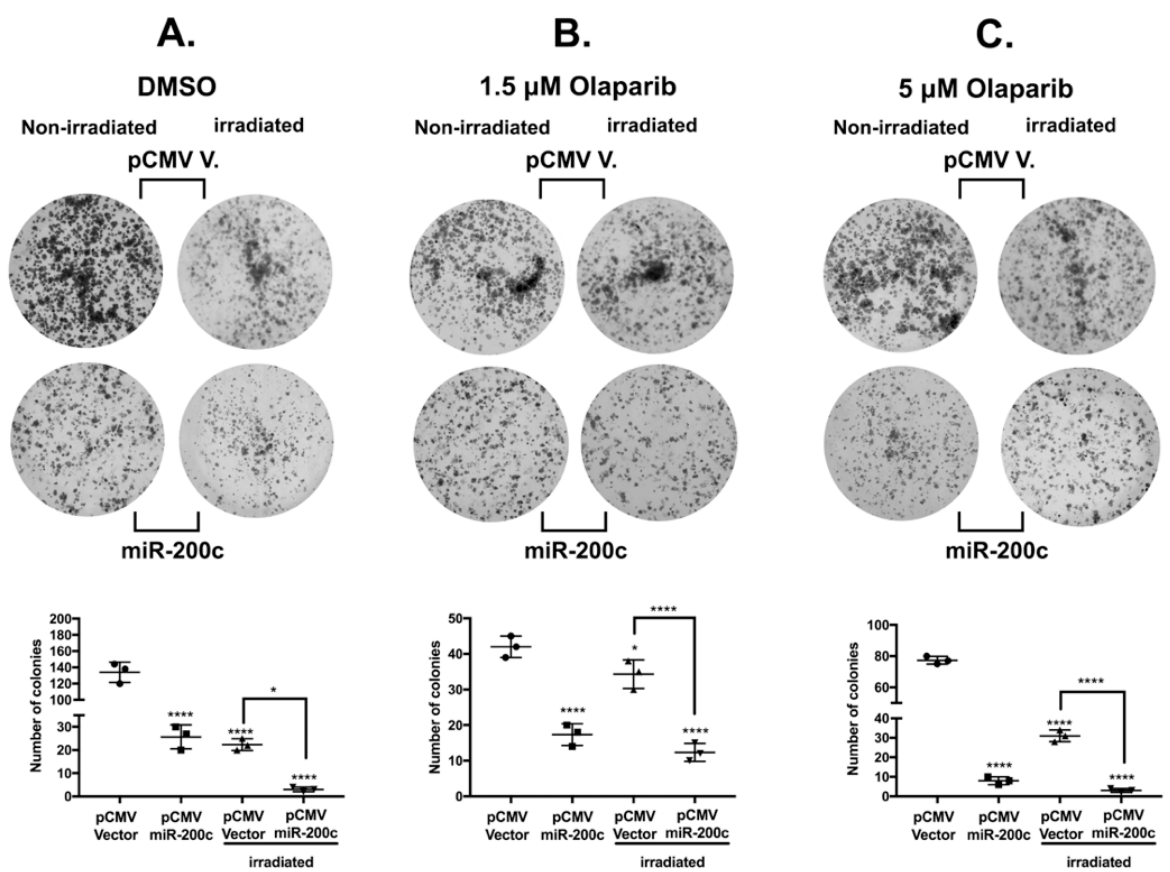
Figure 6. MiR-200c reduces colony formation of the SKOV3 cell line. ( A – C ): Representative images of one well out of three for each experimental condition of the colony formation assay, after two weeks. Under all of the experimental conditions: untreated (DMSO), irradiated only, 1.5 µM olaparib and 5 µM olaparib alone or in combination with irradiation, the number of colonies formation was reduced in the presence of miR-200c. The number of colonies in each experimental condition was determined by ImageJ, using the “analyze particles” command according to the software instructions. Particles considered as colonies under 100 mm 2 pixels were excluded in order to measure only the largest colonies formed. The results of the scanned clonogenic assay images in A, B and C were plotted as means ± standard deviations of three separate experiments, each one with three replicates. Dunnett’s multiple comparisons test was applied for statistical significance in all the scatter dot plots. * p < 0.05, **** p <